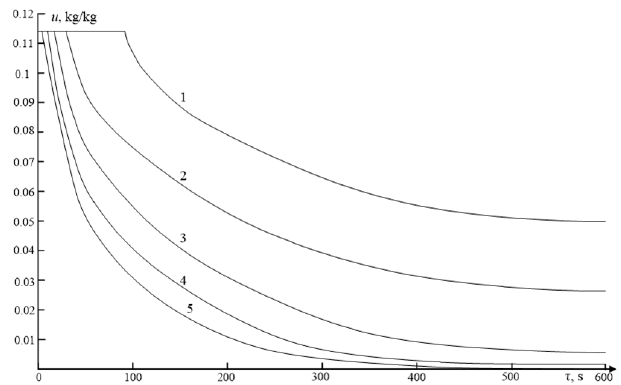
Figure 5. Time evolution of drying front in the pellet at different temperatures of the drying agent T c :